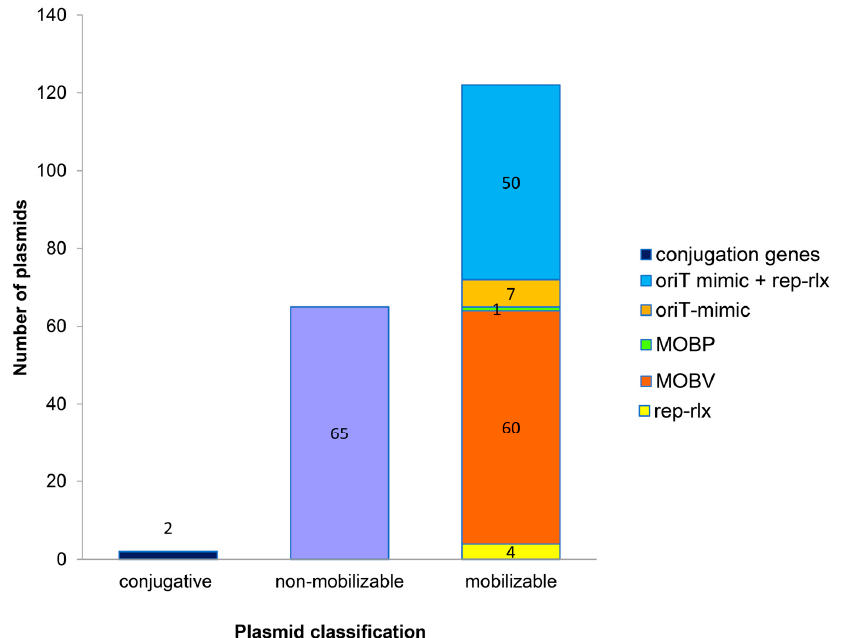
Figure 4. Distribution of the Malaysian MRSA plasmids based on their mobility potential. Note that only two of the identified plasmids (1%, or 2/189) were possibly conjugative, while 64.5% (122/189) plasmids were potentially mobilizable through the conventional mobilization genes mob/pre (of the MOBV family) or mobCAB (of the MOBP family), or through carriage of replicases with relaxase potential ( rep-rlx ) and/or oriT -mimic sequences (i.e., relaxase in trans mechanism). The purple-colored box refers to non-mobilizable plasmids and numbers in the figure refer to the number of